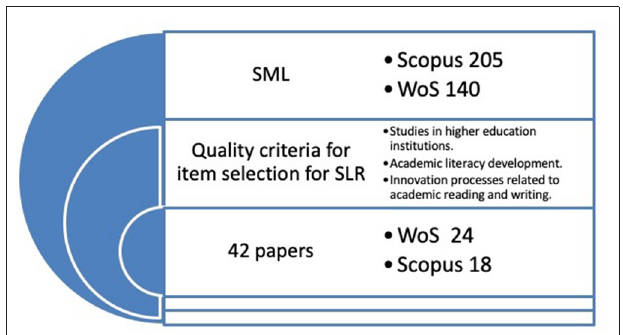
FIGURE 3 | Trends and methodological tools.